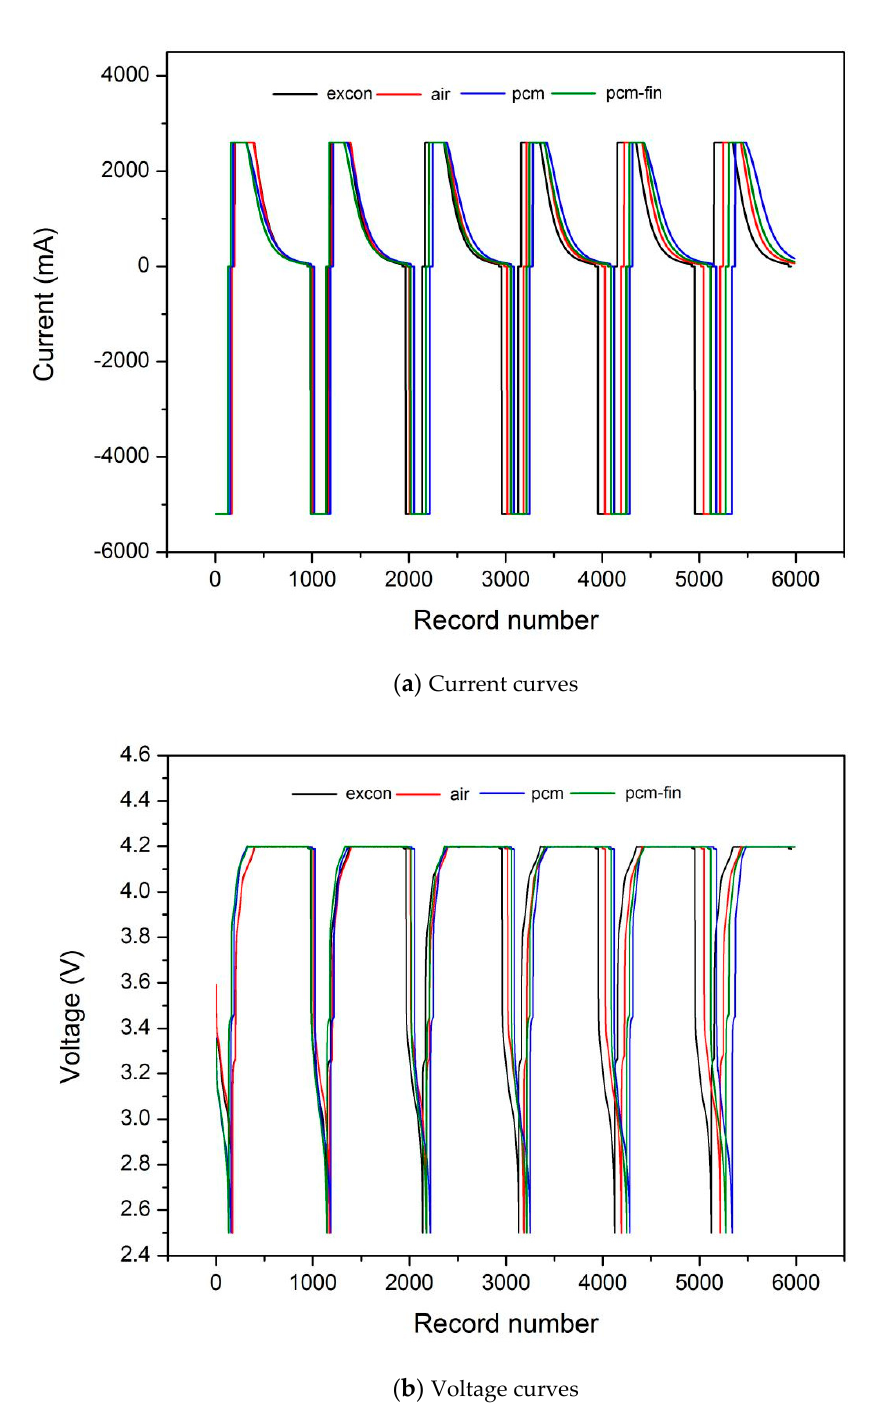
Figure 5. The current and voltage curves of Sanyo LIB.